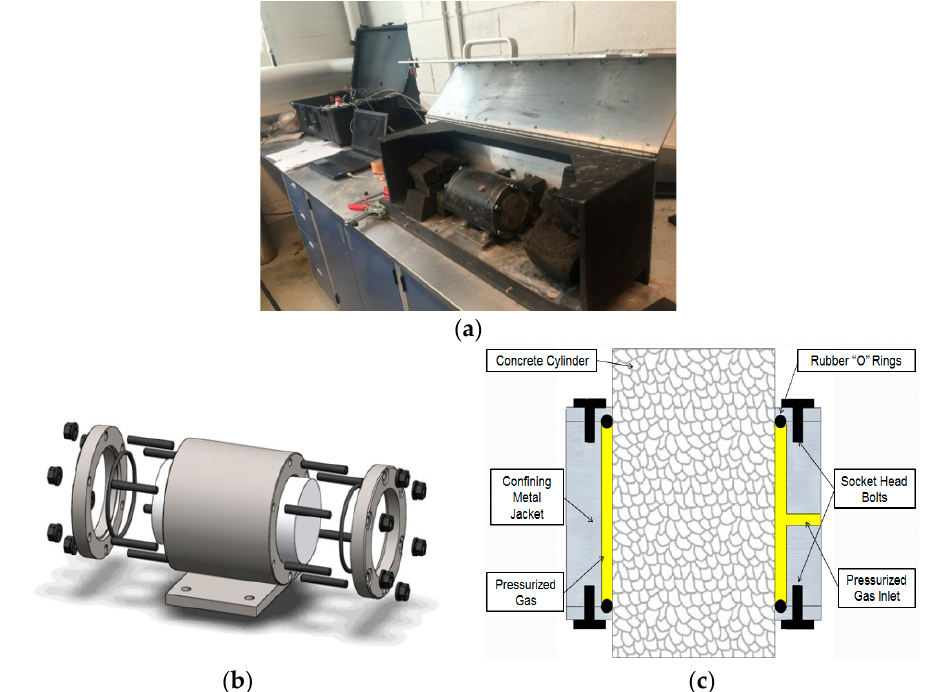
Figure 1. ( a ) Photograph of pressure-tension testing machine; ( b ) Exploded view of the pressure-tension apparatus with concrete cylinder in machine; ( c ) Cross section of pressure-tension apparatus and concrete cylinder [2].